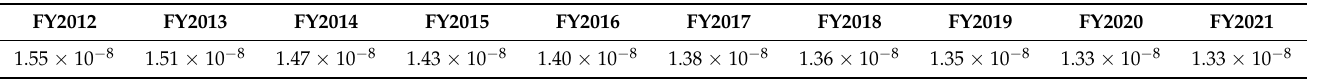
Table 3. Dose coefficient ( DC s) for total activity concentration of 134 Cs and 137 Cs for FY2012–FY2021